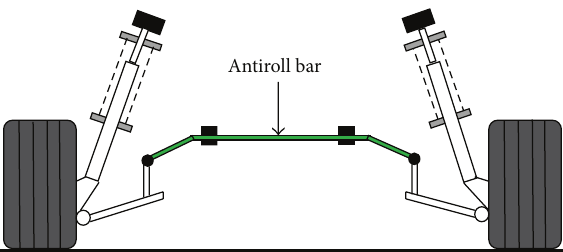
Figure 1: Schematic presentation of an antiroll in action